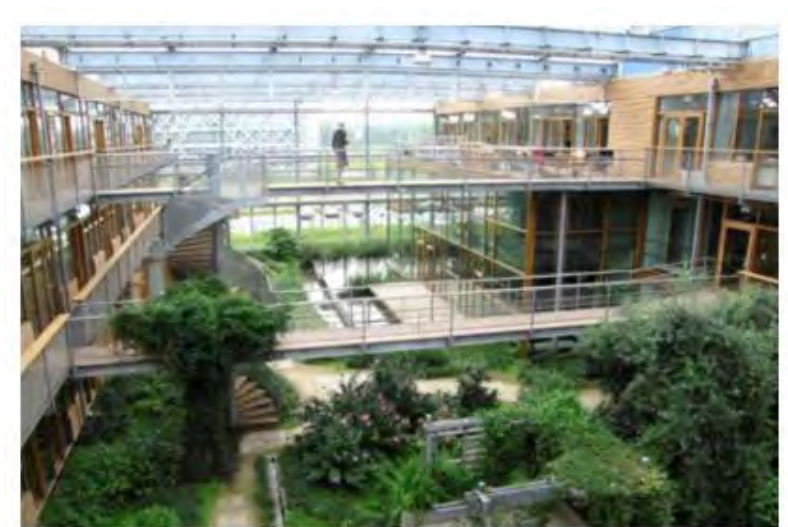
Figure 12. the Lumen Building at the Wageningen Institute, an agricultural institute in the Netherlands, takes the indoor – outdoor idea of modernism to the next level, a world leader in the development of greenhouses (”Larigakis Architecture”, 2015).